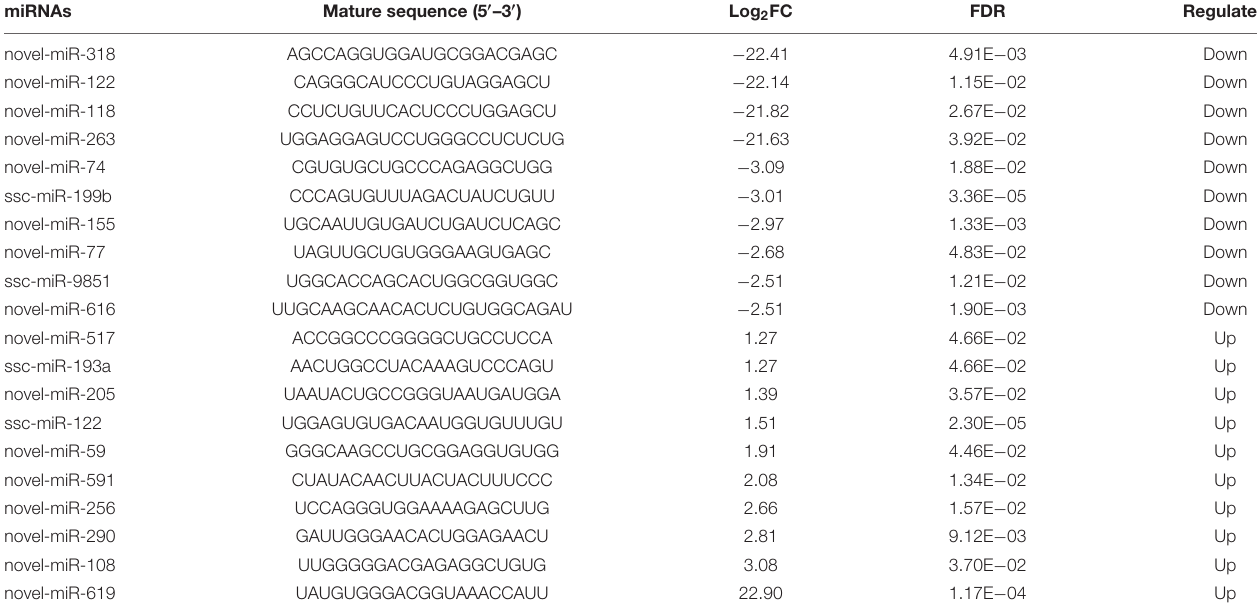
TABLE 2 | Top 10 down- and up-regulated DEmiRNAs in NORFA -reduced porcine GCs. miRNAs Mature sequence (5 (cid:48) –3 (cid:48) ) Log 2 FC FDR